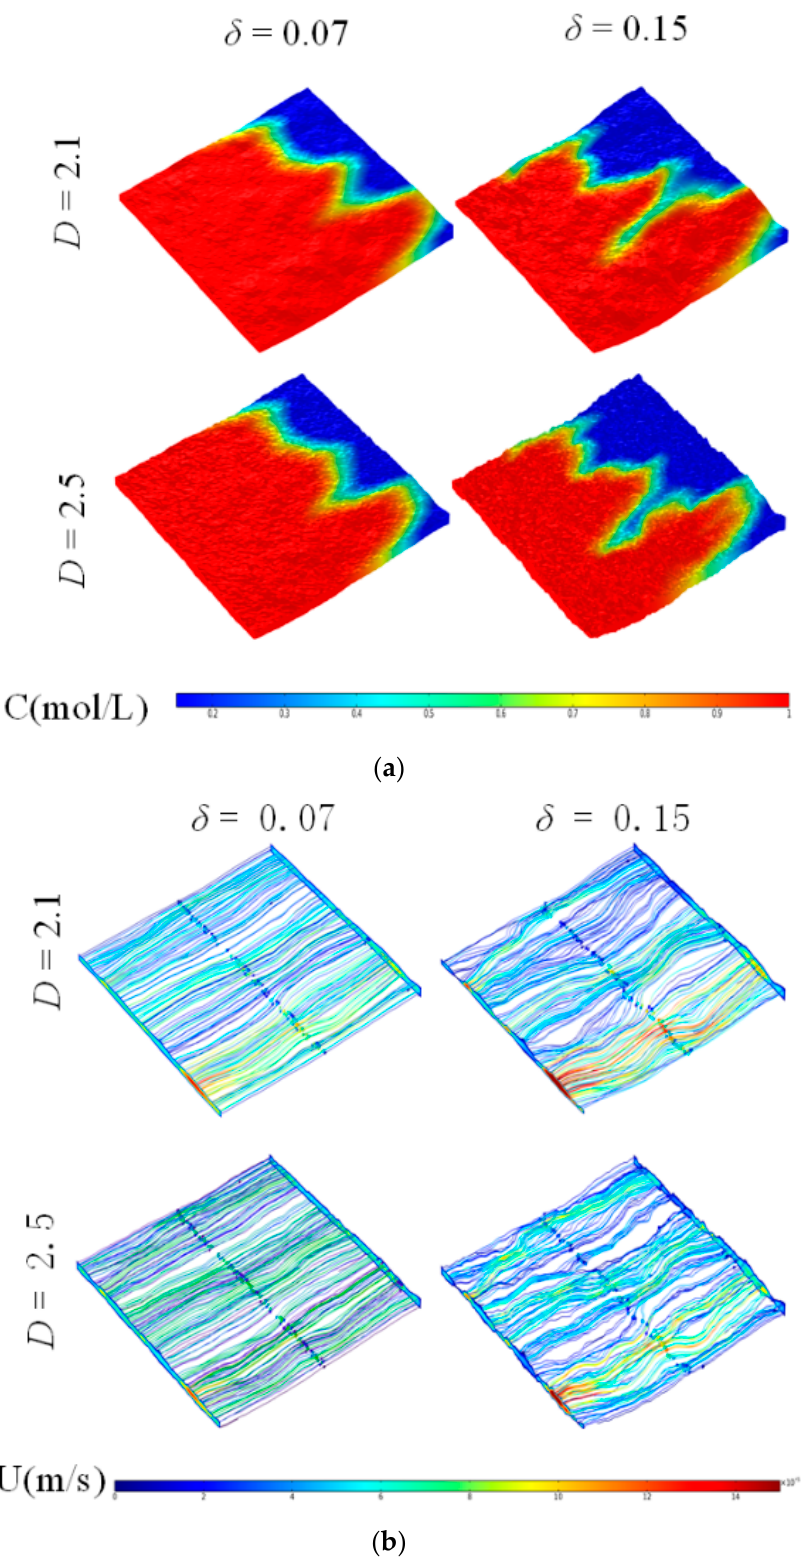
Figure 4. ( a ) Concentration distribution, ( b ) streamline distribution through fractures.